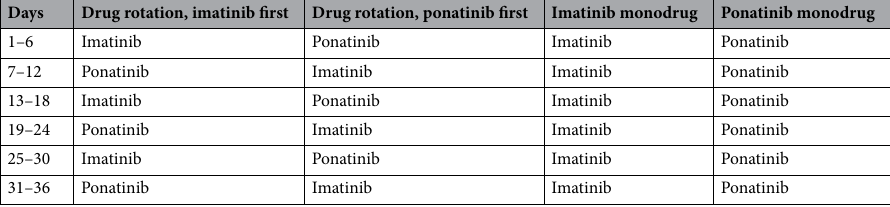
Table 1. Drug rotation exposure